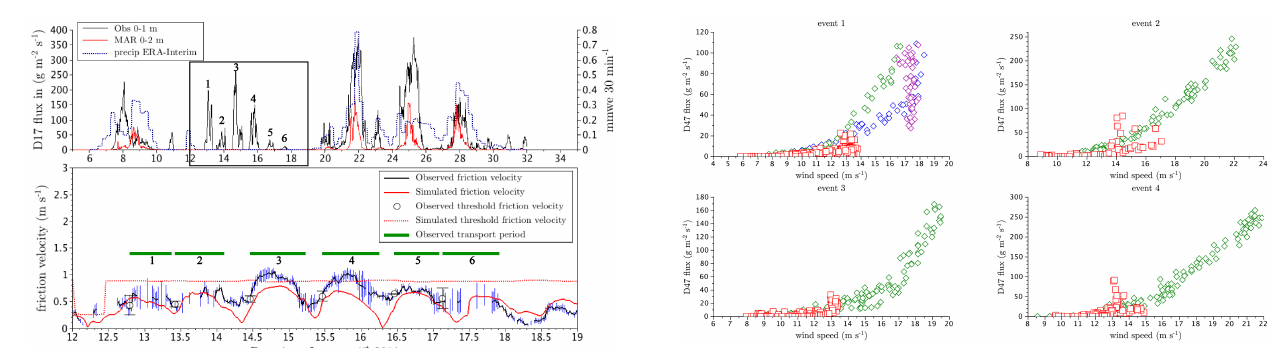
Figure 4. Top panel: comparison between observed aeolian snow mass fluxes from 0 to 1m (black), simulated fluxes from 0 to 2m (red), and precipitation from ERA-Interim at D17. The black frame identifies the period without precipitation analyzed in the bottom panel. Bottom panel: comparison of observed/simulated friction velocity (black line/red line, respectively) and observed/simulated threshold friction velocity (dashed line/black circles, respectively) at D17 for a transport period with no precipitation. The horizon- tal green bars represent the observed aeolian snow transport events numbered from 1 to 6.